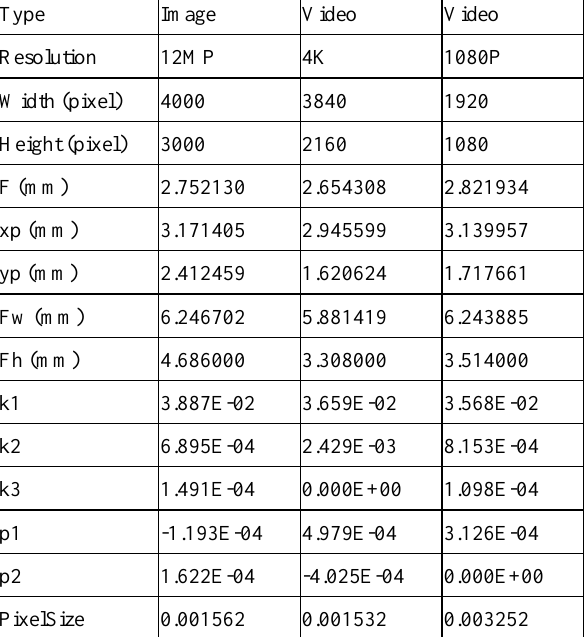
Table 2. Results of camera calibration using Photomodeler